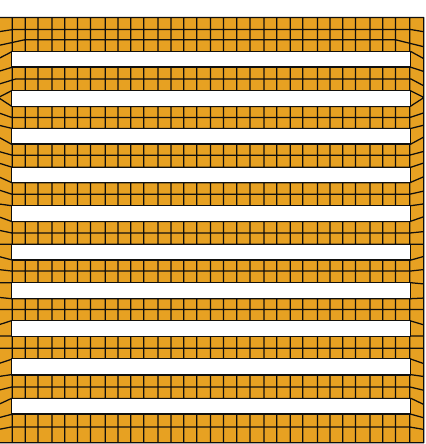
Figure 6: Long hole